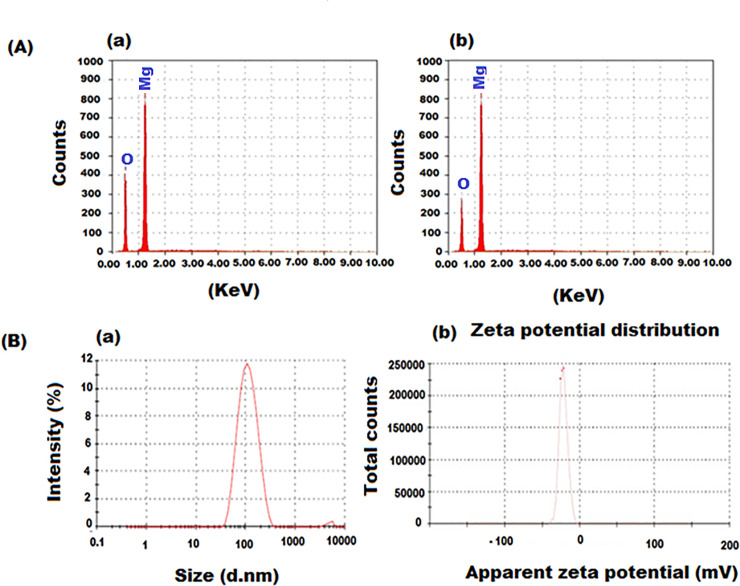
(A) EDS analysis (B) DLS and Zeta potential of MgONPs synthesized by S.costus (Qustal hindi and Qustal bahri), respectively.